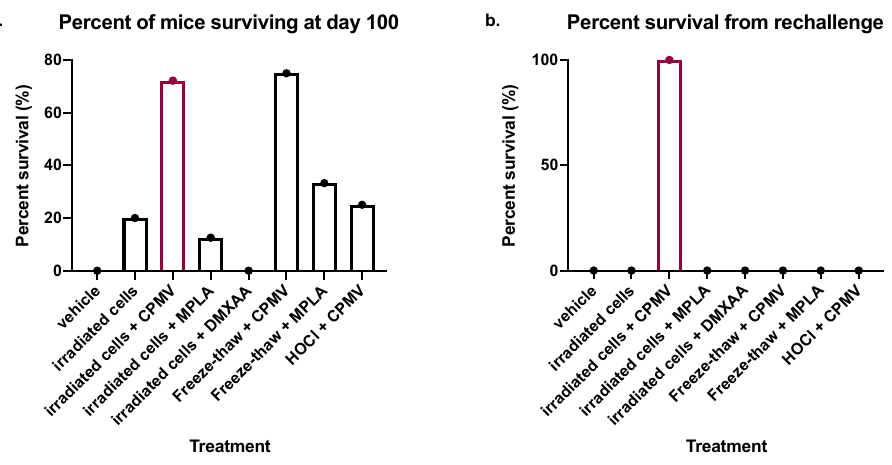
Figure 2. The prophylactic codelivery of irradiated cells and CPMV provides robust, long-term protection from ID8/VEGFA/defb29 tumor challenge and rechallenge. ( a ) Combination data from all survival experiments. Mice received treated ID8/VEGFA/defb29 cells, co-delivered IP with or without adjuvant. The panel shows the percent of mice (out of the total number that received that treatment in all experiments) that survived to day 100 to be rechallenged. ( b ) The panel shows the percent of mice that survived 60 days after being rechallenged. All groups with any mice surviving to rechallenge are included, as are all groups that included irradiated cells and all vehicle-treated mice. ( a , b ) Vehicle-treated n = 24, irradiated cells n = 20, irradiated cells + CPMV n = 20, irradiated cells + MPLA n = 8, irradiated cells + DMXAA n = 8, freeze–thaw + CPMV n = 4, freeze–thaw + MPLA n = 3, HOCl + CPMV n = 4.